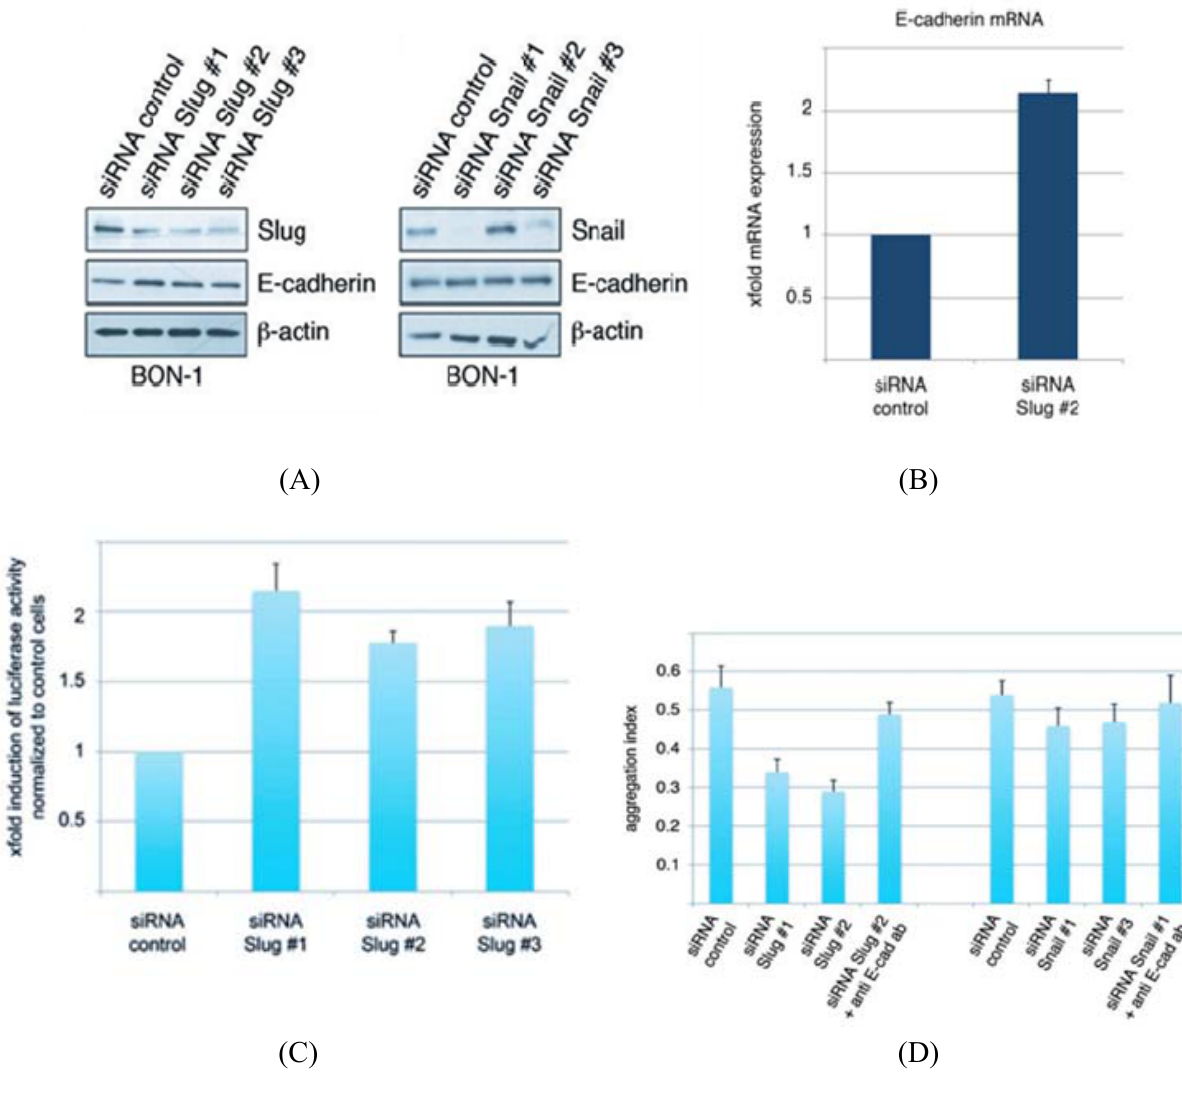
Figure 3. (A) Western blot analysis revealed expression of the EMT markers Snail and Slug and E-cadherin;(B) This upregulation of E-cadherin was also detectable